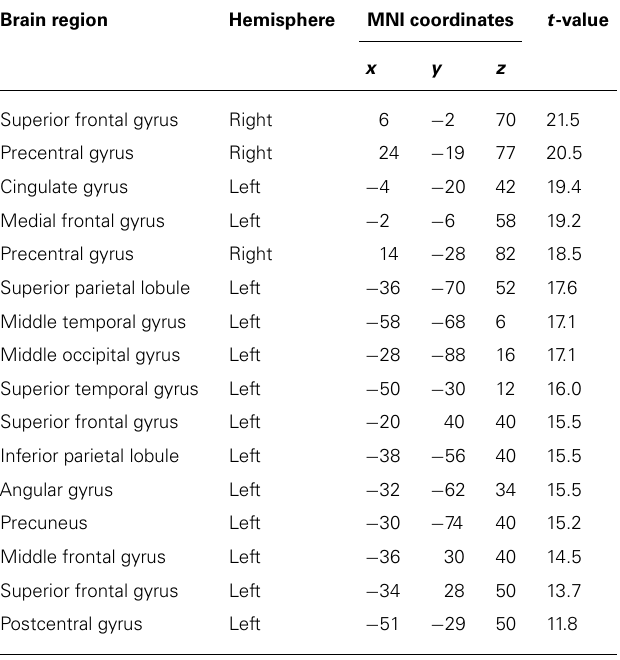
Table 1 | Brain regions showing significant IC with the left M1 during real movements.